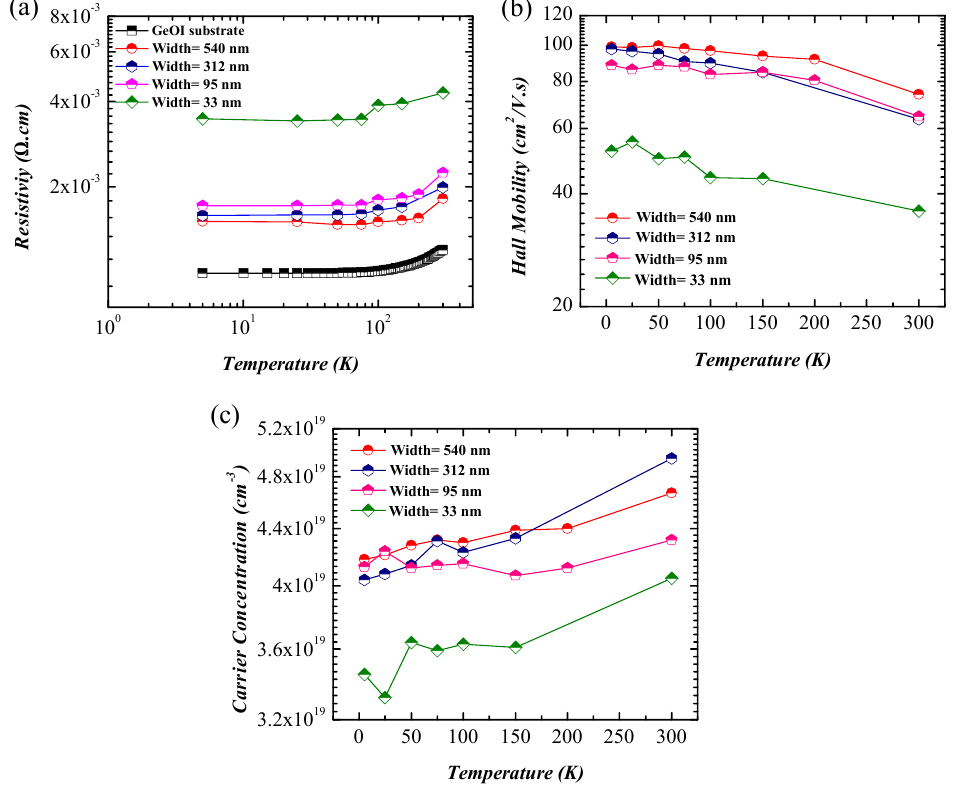
Figure 7. Temperature-dependent ( a ) resistivity, ( b ) Hall mobility, and ( c ) carrier concentration of GeNWs with different